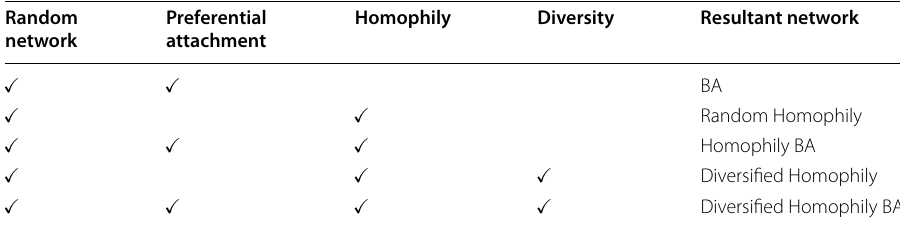
Table 1 Relationship between the network